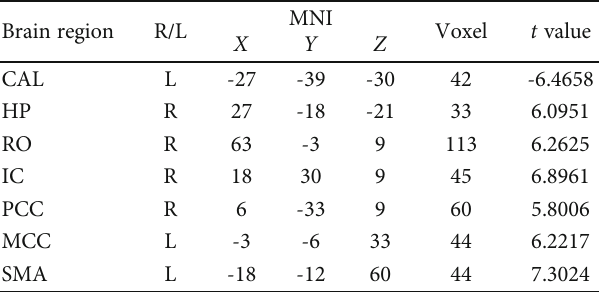
Figure 6: Regions showing signi fi cantly di ff erent EC with the rACC in placebo status compared with pain status Table 3: Locations of the regions showing signi fi cantly altered EC with the rACC in placebo status compared with pain status in EG ( p < 0 : 05 , FDR < 0 : 05 ).